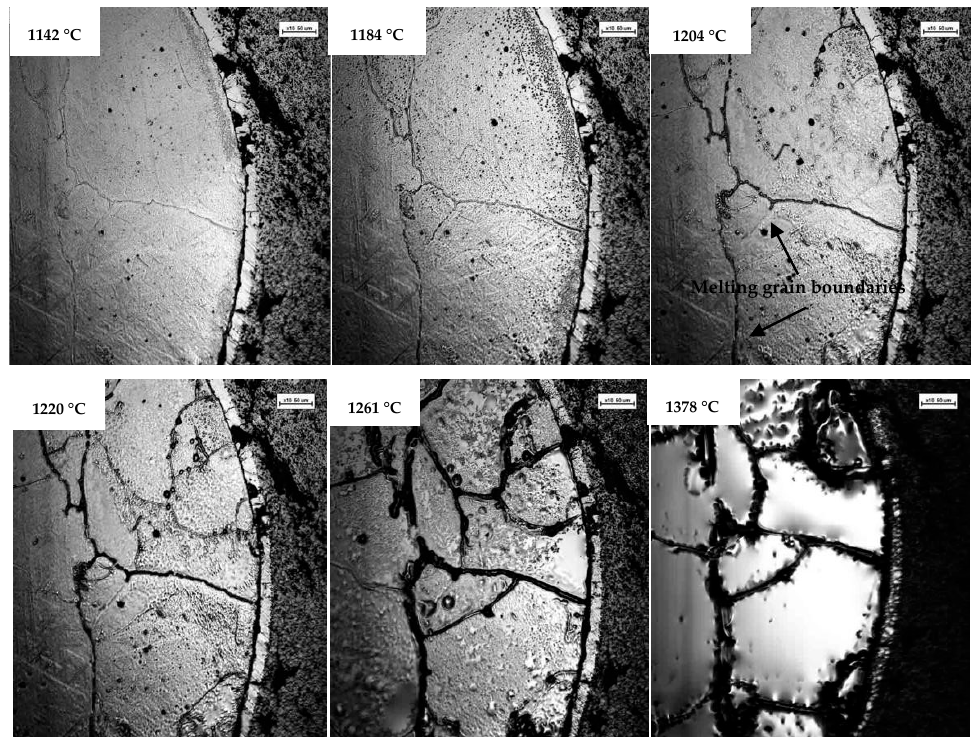
Figure 8. Composite interface changes of WC /HSS at ultra-high temperature laser confocal.